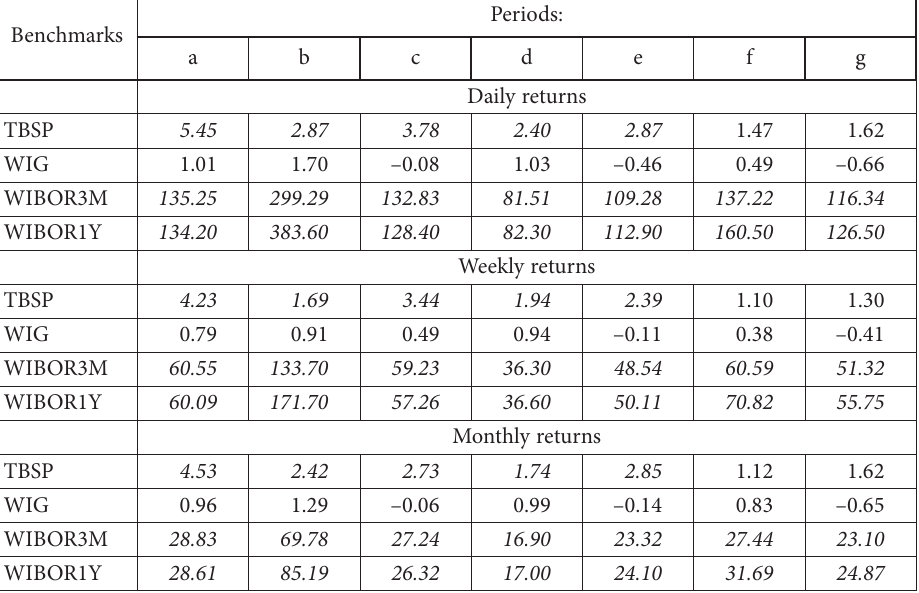
Table 1. Values of the test statistic (1) verifying the hypothesis that returns from the benchmarks equal zero (source: own calculations) Benchmarks